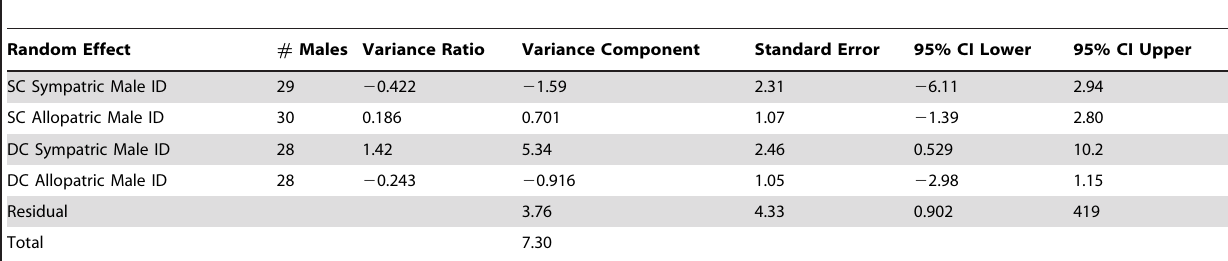
Table 4. Components of variance in female discrimination differential explained by male identity (ID), estimated as random effects from a general linear model with REML.